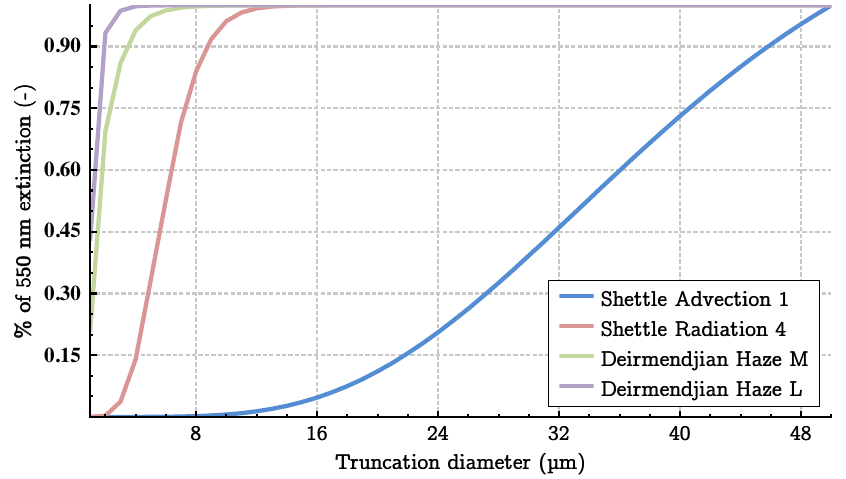
Figure 4. Percentage of 550 nm extinction versus truncation diameter ( D